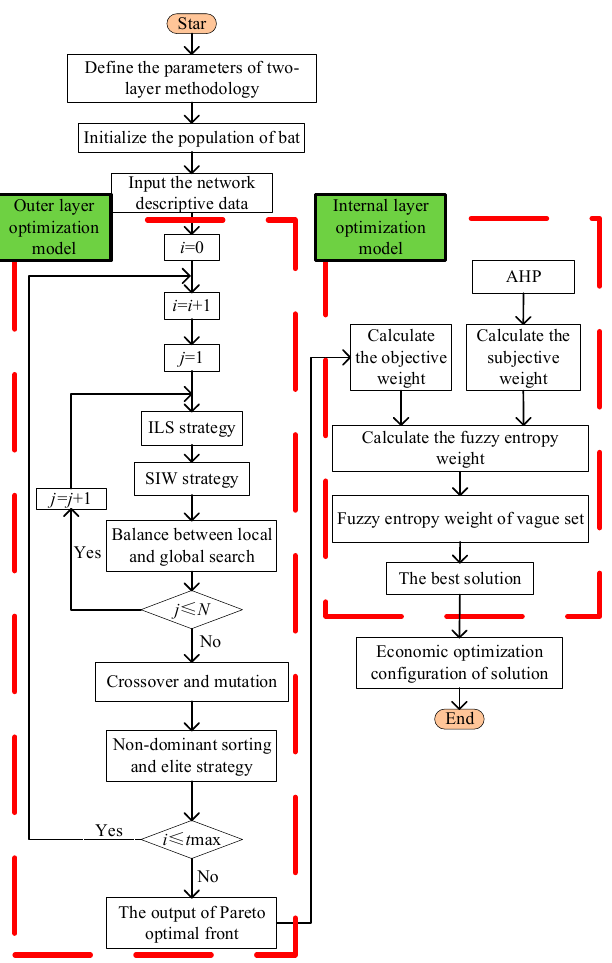
Figure 4. The flowchart based on a two-layer optimization model.